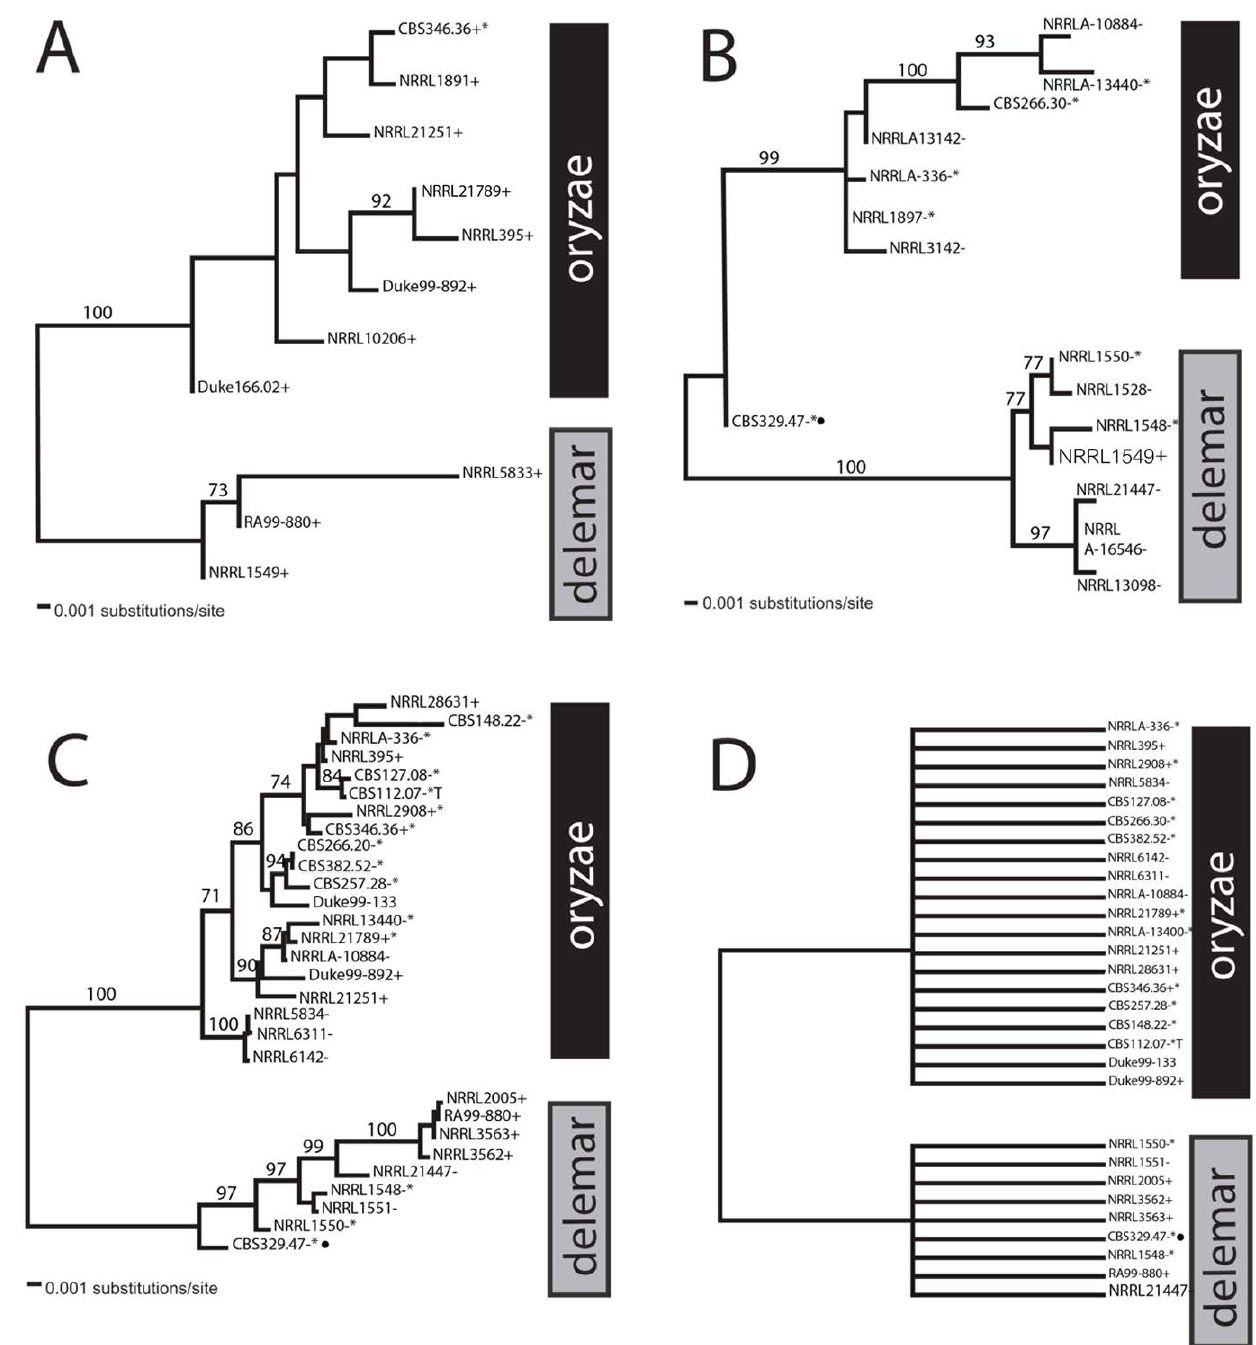
Figure 3. Maximum Likelihood phylogenies of the Rhizopusoryzae complex clearly delimit the two cryptic species, Rhizopusoryzaes. s. and Rhizopusdelemar . (A) sexP alleles, (B) sexM alleles, (C) concatenated phylogram of rDNA ITS1-5.8S-ITS2, RPB2 , TPT gene, and RNA helicase gene, and (D) four-gene strict consensus tree. Analysis included a total of 458 ( + ), 635 ( 2 ) and 3064 (MLS) nucleotide characters. ML bootstrap proportions higher than 70 are shown above the nodes. Asterisks (*) indicate strains that produced zygospores. Filled circles indicate a single R. delemar strain, CBS329.47, closest to the ancestral state.